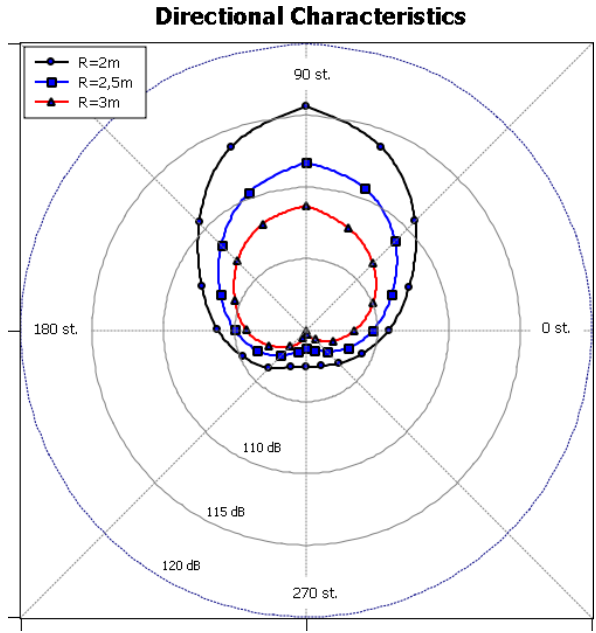
Figure 6: Directional characteristics for three different distances of the sound level meter: R = 2 m, R = 2.5 m, R = 3 m